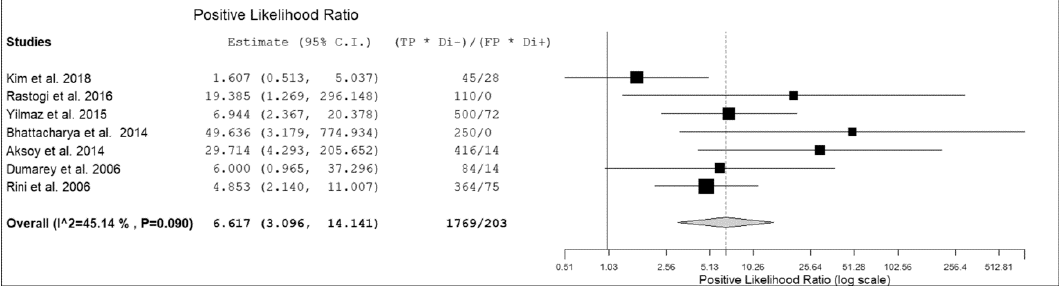
Figure 3. Forest plot of individual studies and pooled positive likelihood ratio of 18 F-FDG-WBC PET or PET / CT in patients with suspicious infectious diseases, including 95% confidence interval (95% CI). The size of the squares indicates the weight of each